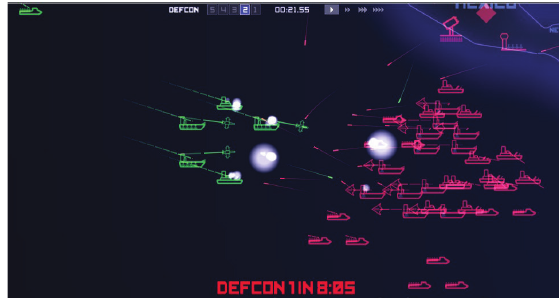
Figure 5: Two fleets attacking each other in